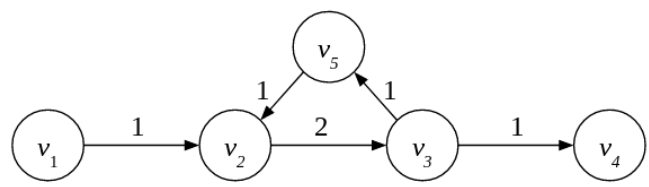
Figure 6. An obligation network with a chain and a cycle.